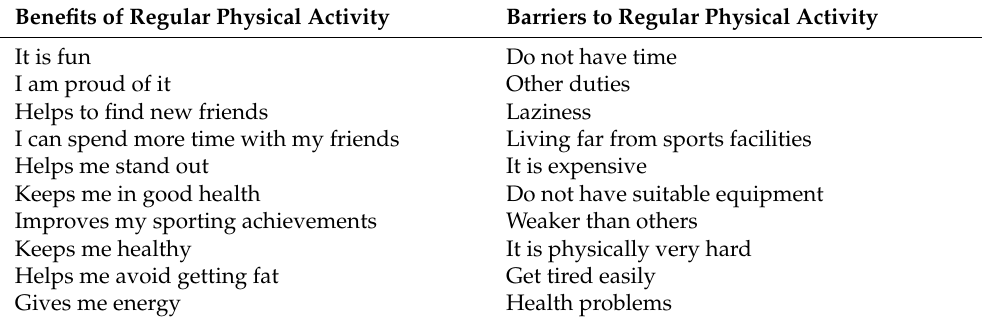
Table 2. Student-level statements used to measure barriers and benefits of being regularly physically